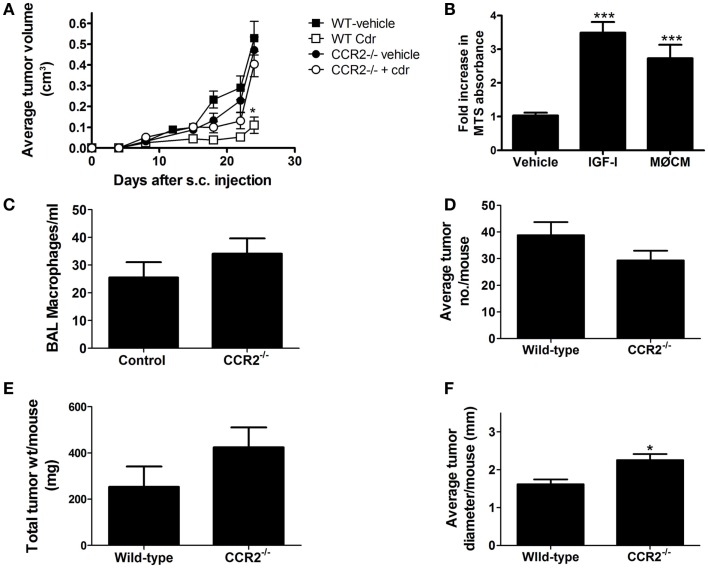
Clodronate reduces syngeneic implant growth in wild-type (WT), but not CCR2−/− mice. (A) E9 cells were injected into the flank of female BALB/cJ (WT) or CCR2−/− mice. After tumors were established (8 days post injection), clodronate-containing or vehicle liposomes were injected IV once/week until sacrifice. Tumors were measured 2×/week and volumes calculated. Clodronate liposome treatment (Cdr) decreased tumor growth in wild-type mice (*p < 0.05, n = 10–12 mice/group from two independent experiments). (B) E9 cells were cultured in serum-free media (vehicle), 50 ng/ml IGF-I containing media, or macrophage conditioned media (MΦCM). Cell density was determined by MTS and graphed as fold-increase over control (mean ± SEM, ***p < 0.001 vs. control). (C–F) Wild-type BALB/cJ and CCR2−/− mice were injected with 1 mg/g urethane once/week for 6 weeks. BALF and tumors were harvested 42 weeks after the first injection and BAL macrophages (×1000) counted, and lung tumors counted, measured, and weighed (mean ± SEM, *p < 0.05 vs. wild-type, n = 5).